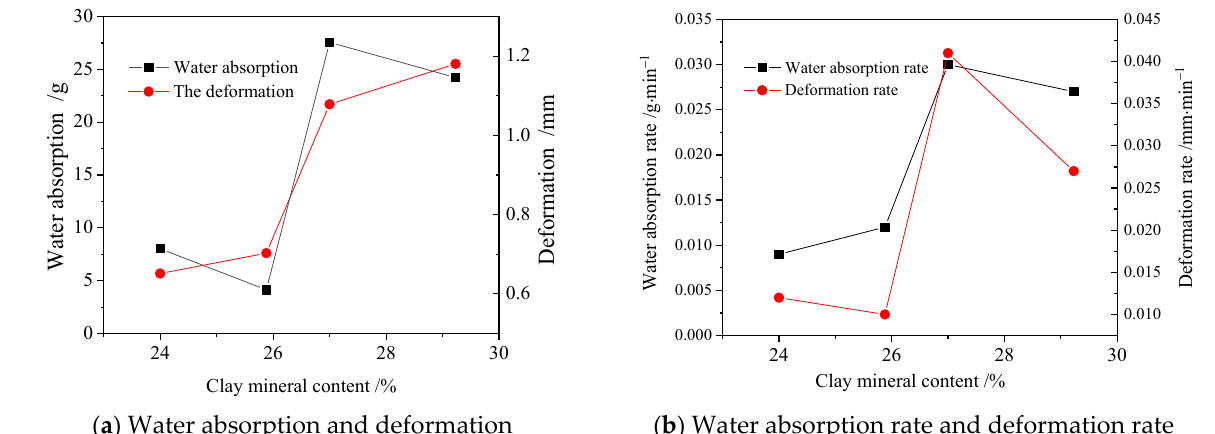
Figure 11. Relationship between clay mineral content and deformation.